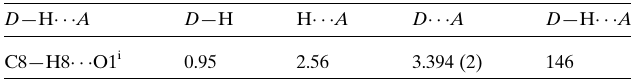
Table 1 Hydrogen-bond geometry (A˚ , (cid:3) ).